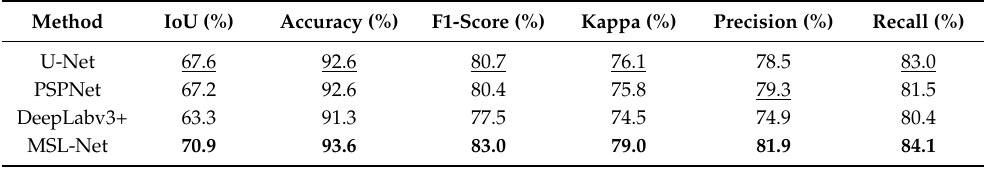
Figure 9. Examples of the segmentation results obtained by different methods. ( a – d ) Results selected from the Massachusetts dataset. Table 7. Metrics produced on the Massachusetts dataset. The highest scores are bolded; the second- highest scores are